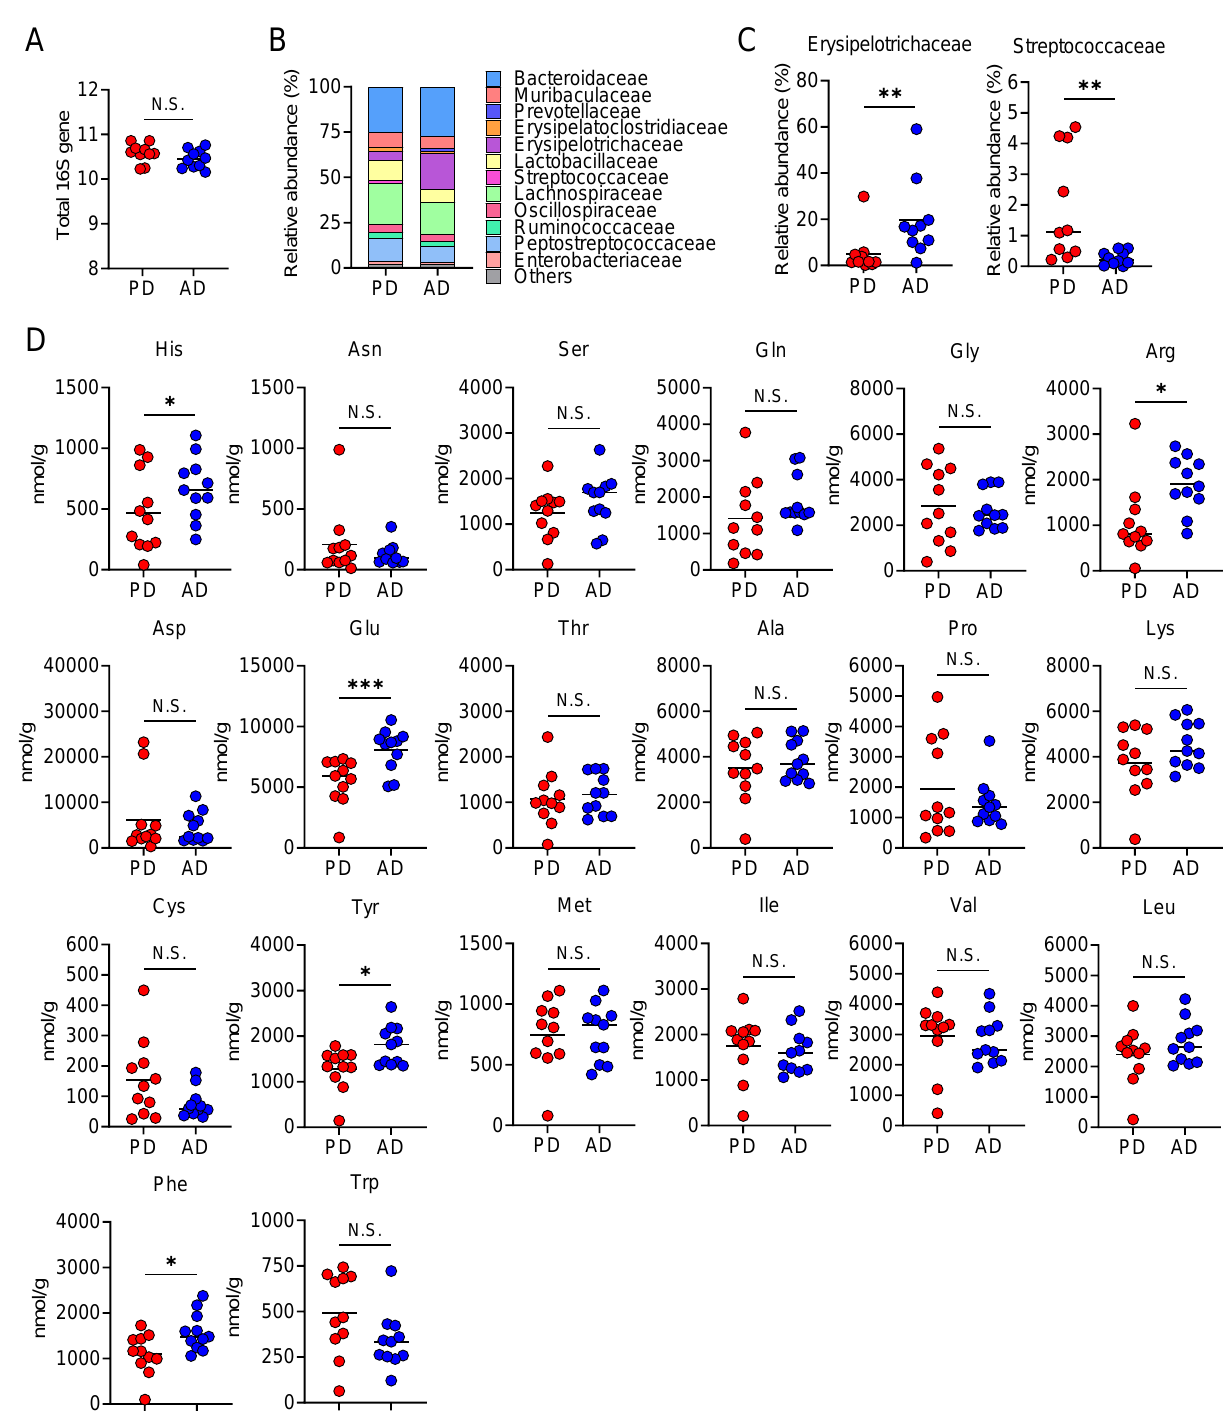
Figure 5. An amino acid-based diet changes gut microbiota composition and fecal amino acid levels. Mice fed each diet (PD, regular purified diet; AD, amino acid-based purified diet) for 2 weeks ( n = 6 in each group). ( A ) Total bacterial number in the feces. ( B ) Relative abundance of operational taxonomic units (OTUs) in fecal samples from each group. The various colors correspond to each bacterial order. ( C ) Relative abundance of OTUs assigned to Erysipelotrichaceae and Streptococcaceae families. ( D ) Fecal levels of each amino acid. Each dot represents an individual mouse, and horizontal bars indicate mean values. Statistical significance was assessed by ( A ) unpaired Student’s t -test, ( C ) Mann–Whitney test, or ( D ) unpaired Welch’s t -test. * p < 0.05; ** p < 0.01; *** p < 0.001; N.S., not significant.